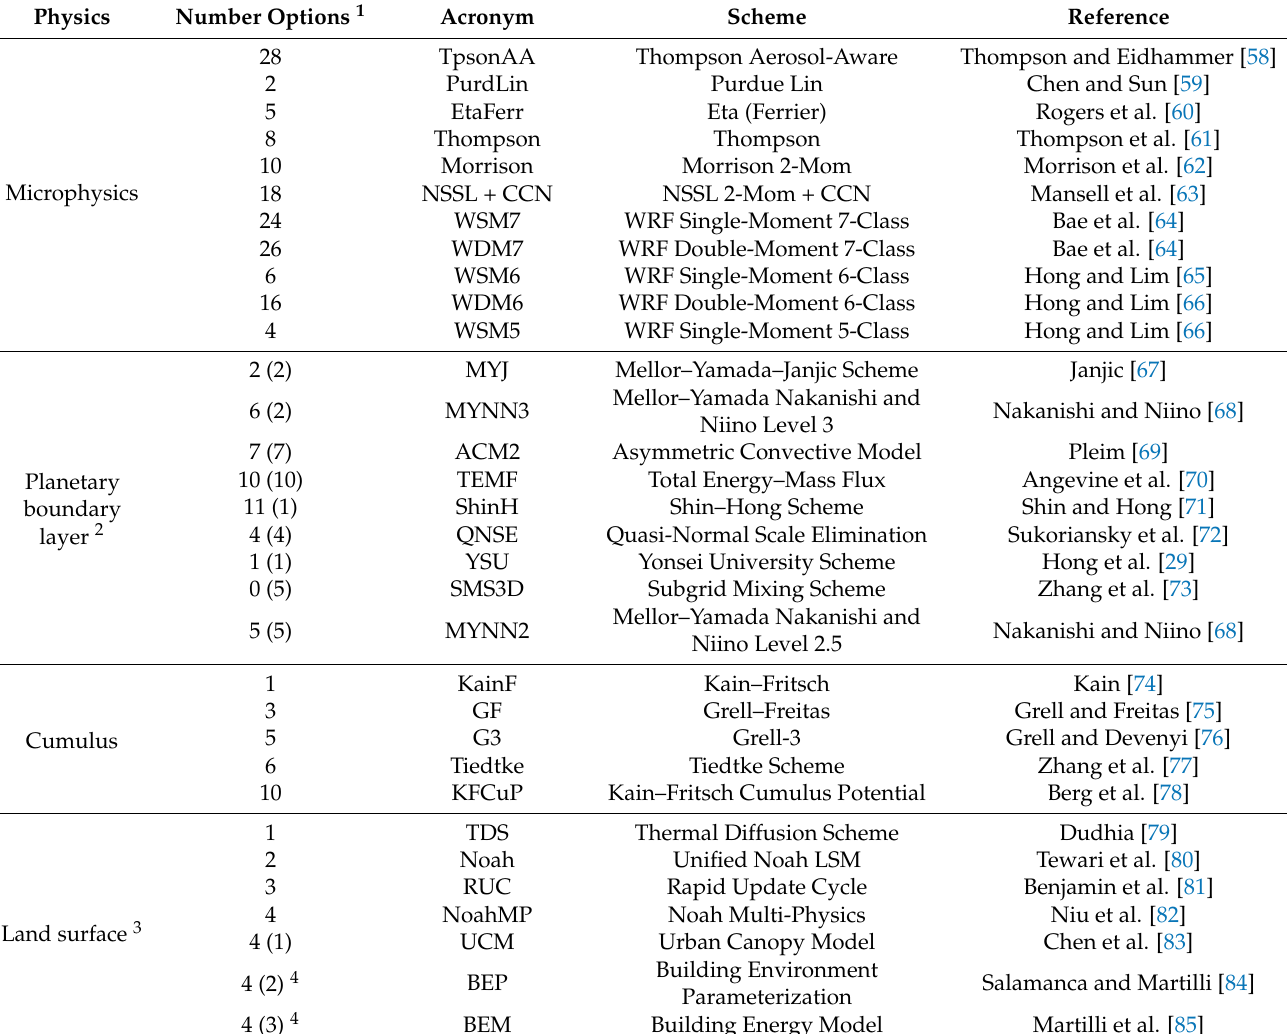
Table 2. Physical schemes tested in the